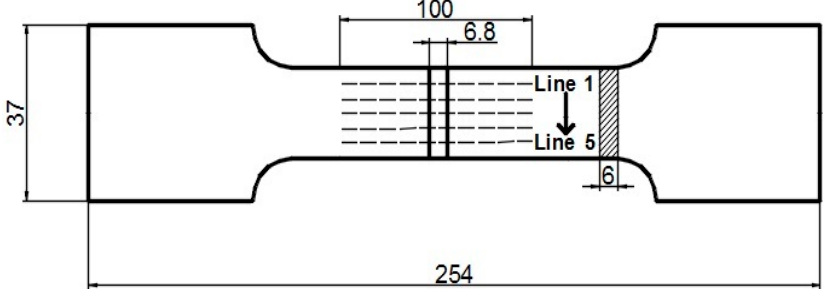
Figure 1. Geometry and dimensions of the specimen used in the experiments and scanning lines (in mm).